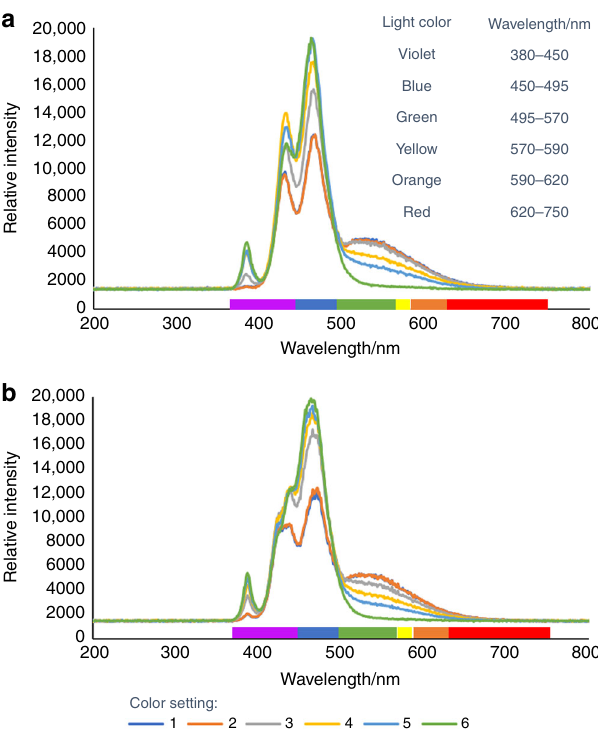
Fig. 1 Comparison of a commonly used light source. a Spectral output overlays of a 34 W blue LED (A) at intensity setting 10 and color settings 1 – 6. b Spectral output overlays of a 34 W blue LED (B) at intensity setting 10 and color settings 1 – 6. LED A and B are the same maker and model from different batches; both are emitting from violet to red light. Figure adapted from (https://doi.org/10.1002/cptc.201900203). Copyright Wiley-VCH Verlag GmbH & Co. KGaA. Reproduced with permission.